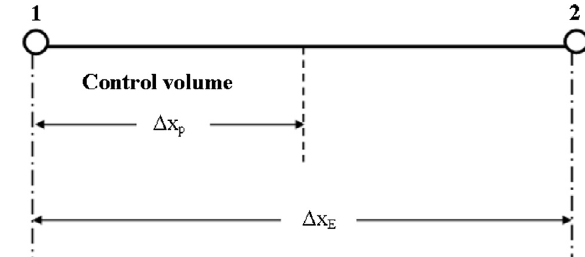
Figure 5. Control volume for the 1st element.